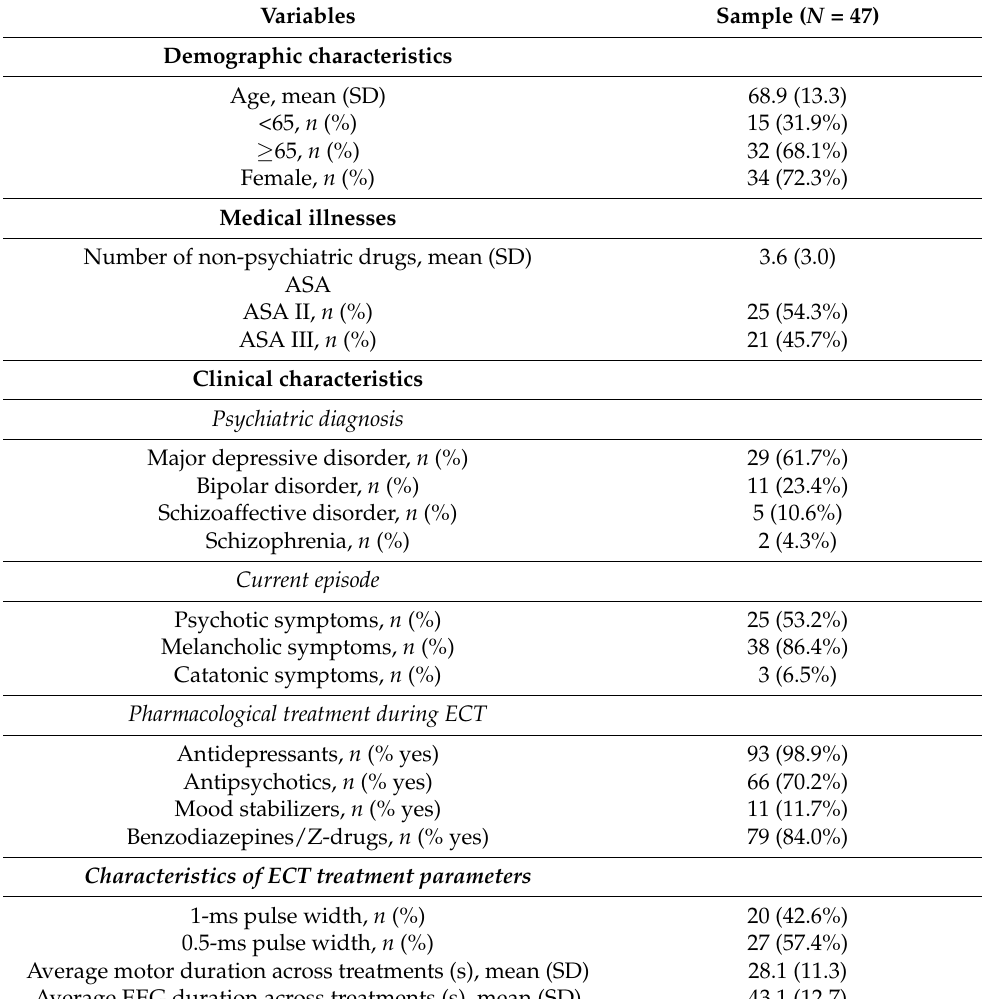
Table 1. Demographic, clinical, treatment, and ECT characteristics of the